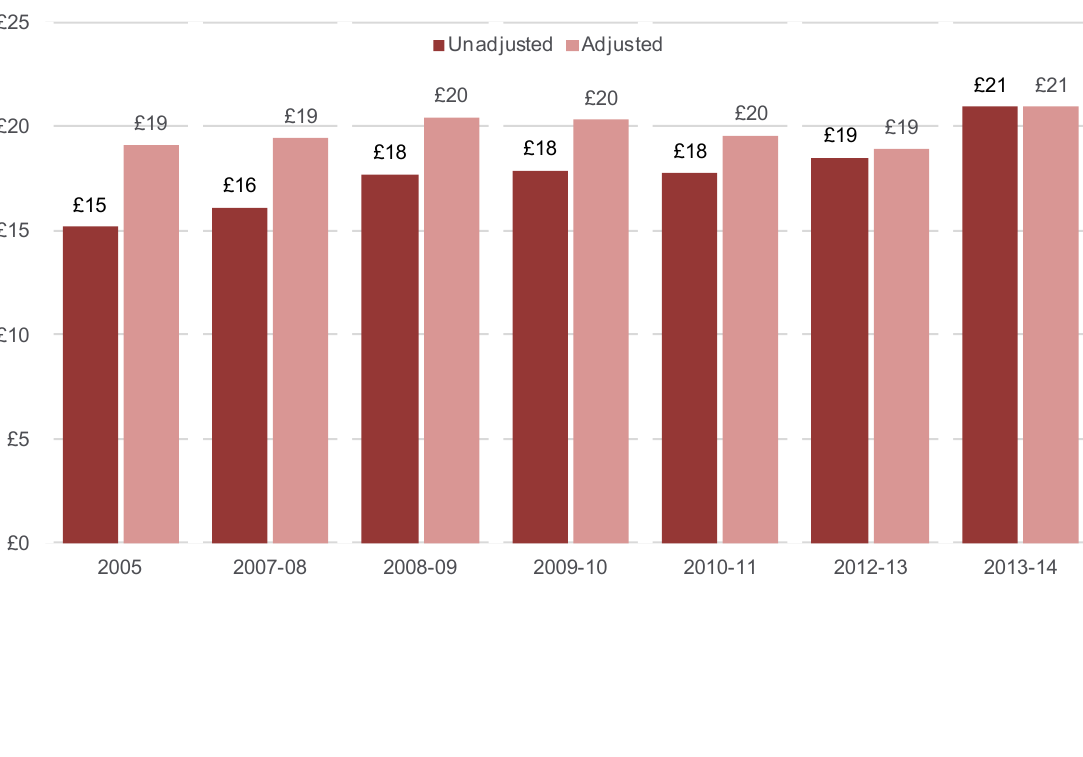
- Table 6: Amount given to charity in the 4 weeks prior to interview, 2005 to 2013-14